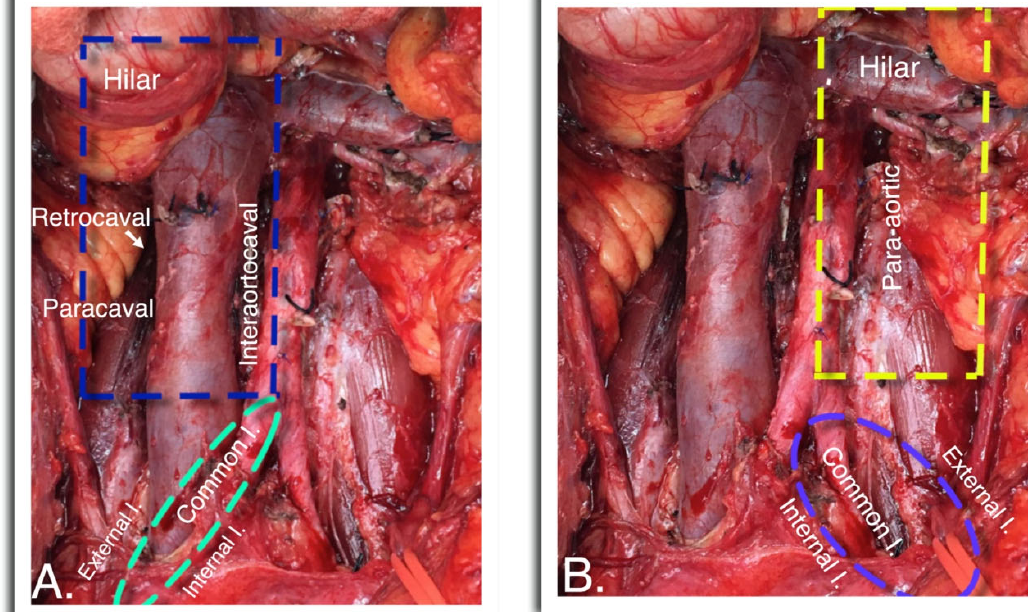
Figure 3. Regional LND templates for anatomical LND in UTUC. ( A ) Blue template for a renal pelvis or proximal or mid ureteral right ‐ sided UTUC. Green template for distal or mid ureteral right ‐ sided UTUC. ( B ) Yellow template for a renal pelvis or proximal or mid ureteral left ‐ sided UTUC. Purple template for distal or mid ureteral left ‐ sided UTUC.